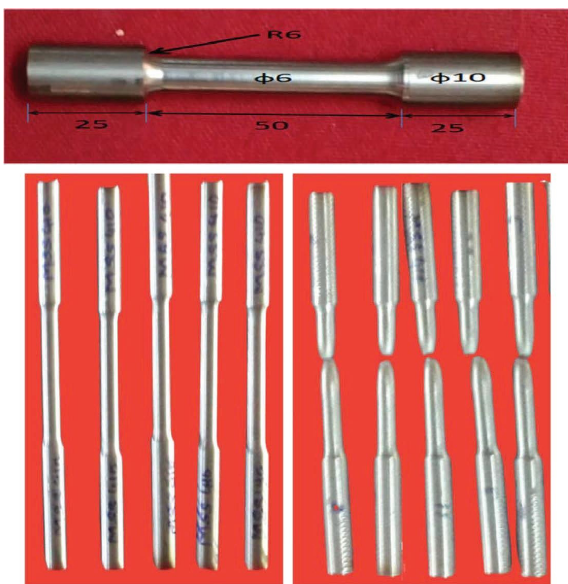
Figure 3: Tensile test specimen dimension, before test, and after test specimens. Table 4: Mechanical properties of Inconel 718 and AISI 410 dissimilar joints. Sample